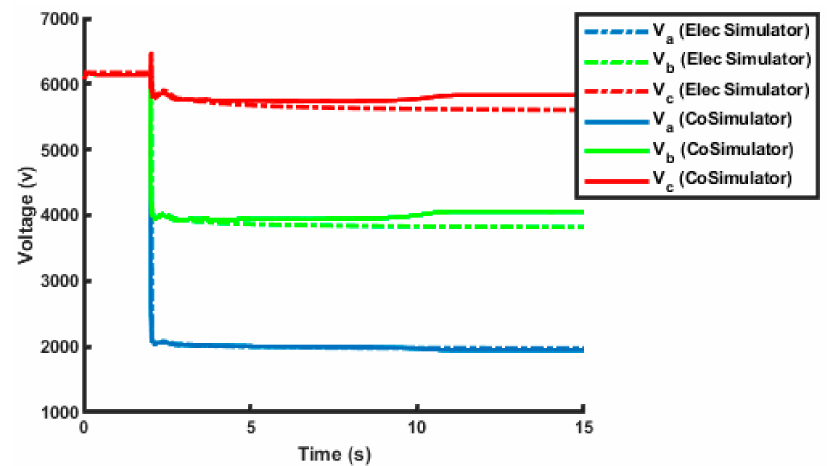
Figure 6. The phase voltages at the motor terminals; single-phase fault at t = 2